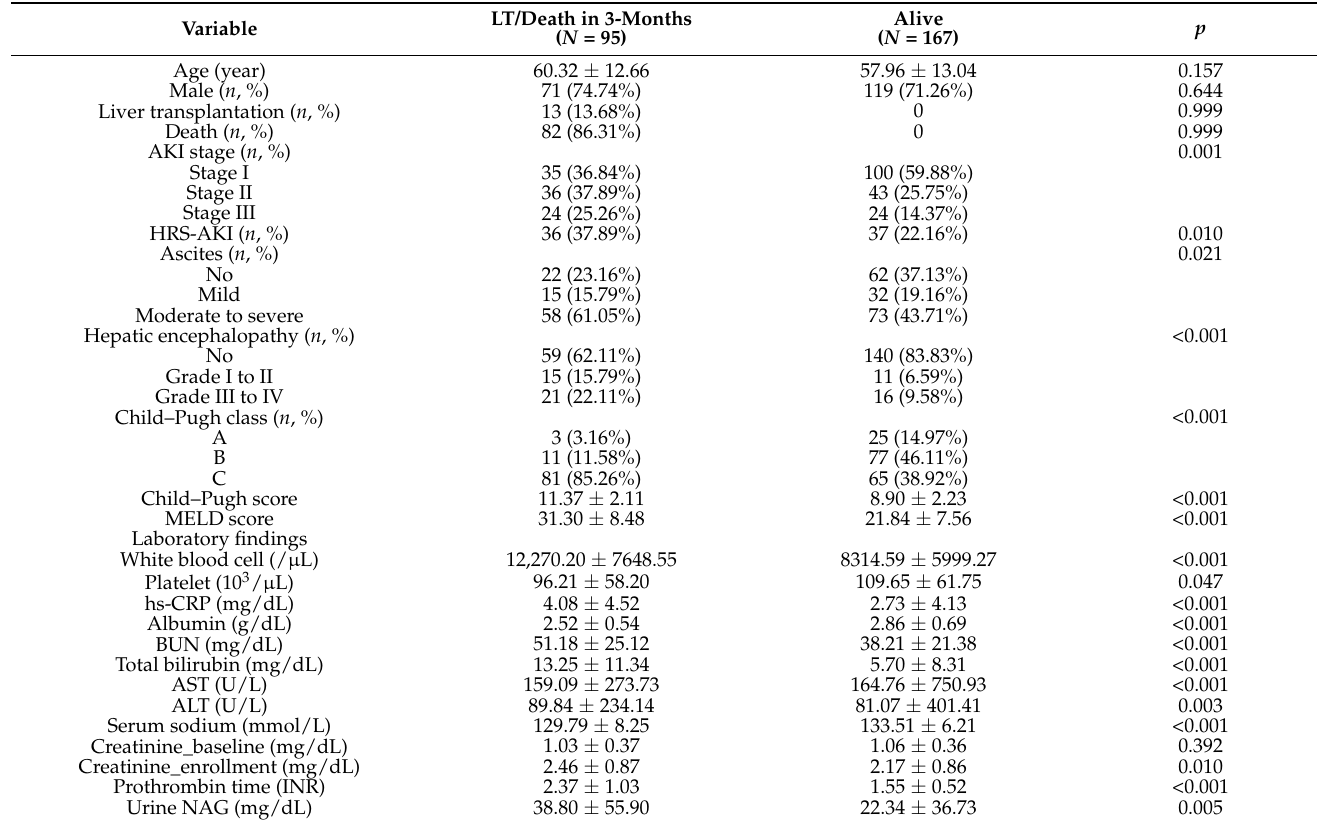
Table 2. Comparison of baseline characteristics according to clinical outcomes.